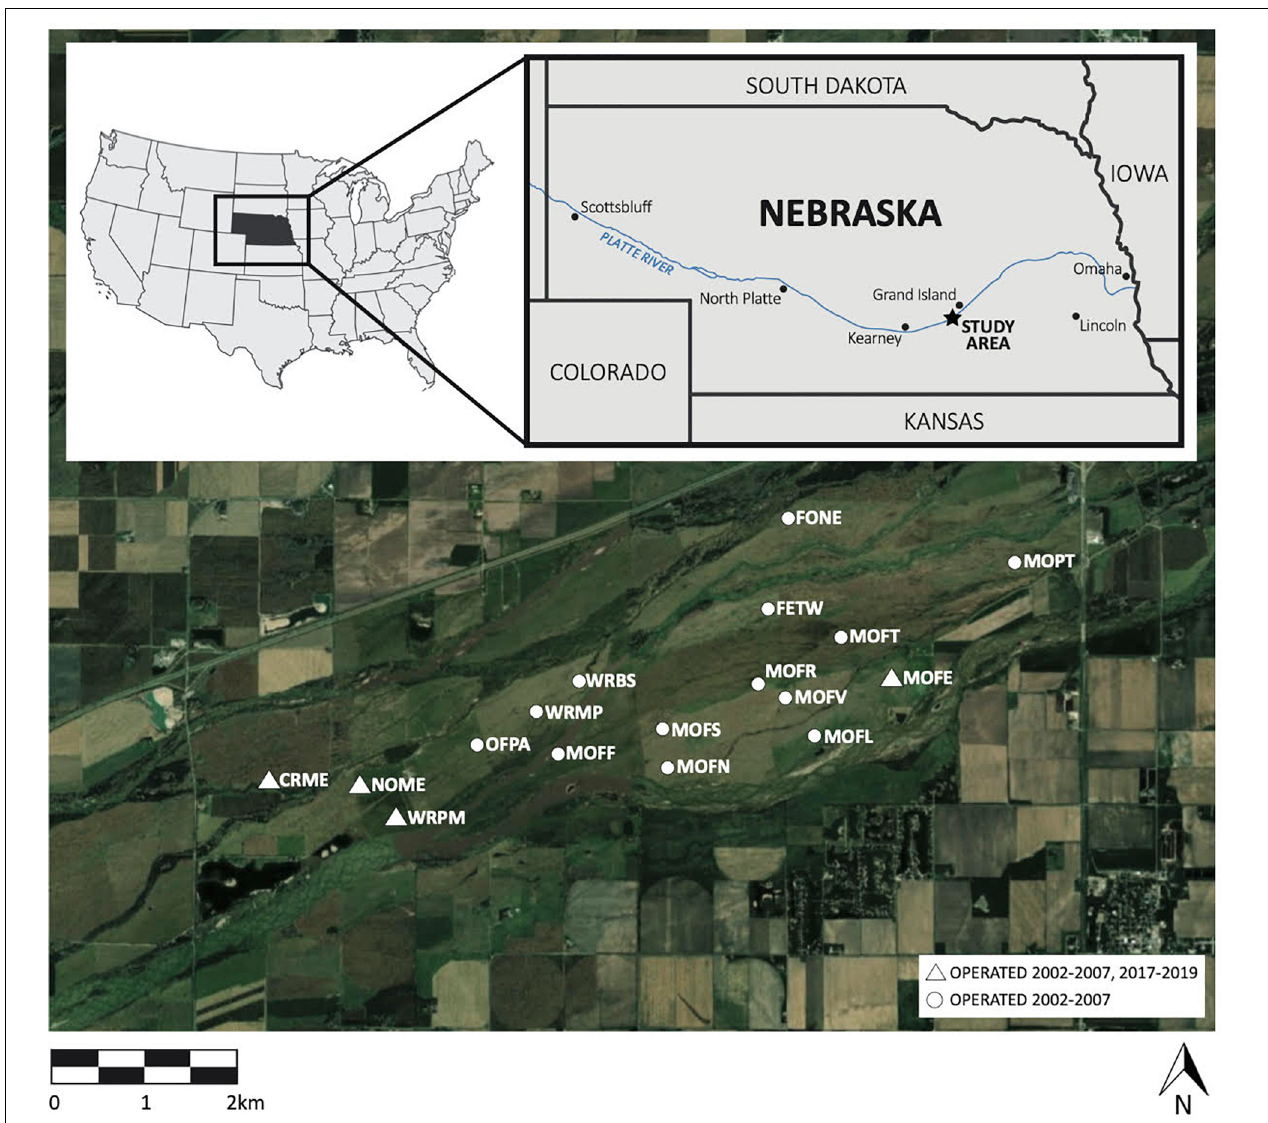
FIGURE 1 | Map of study area in North American Great Plains indicating bird sampling